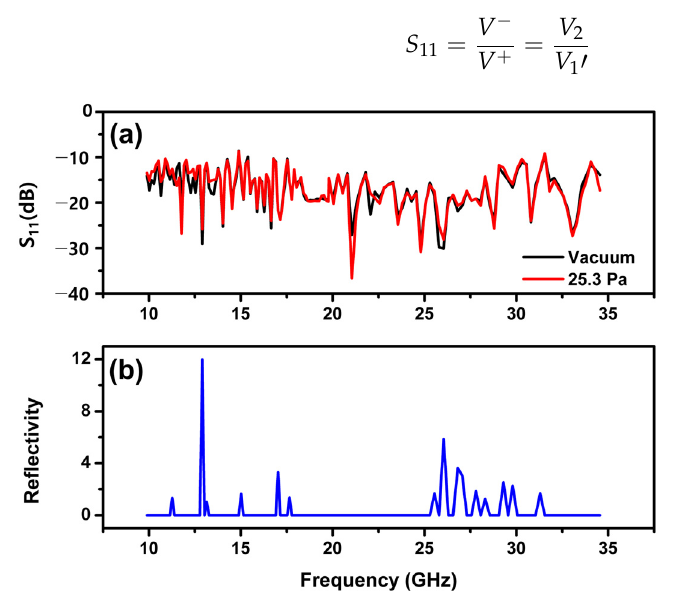
Figure 4. Reflectometry experiment results according to frequency sweep; ( a ) S 11 measurement results ( b ) reflectivity measurement results.